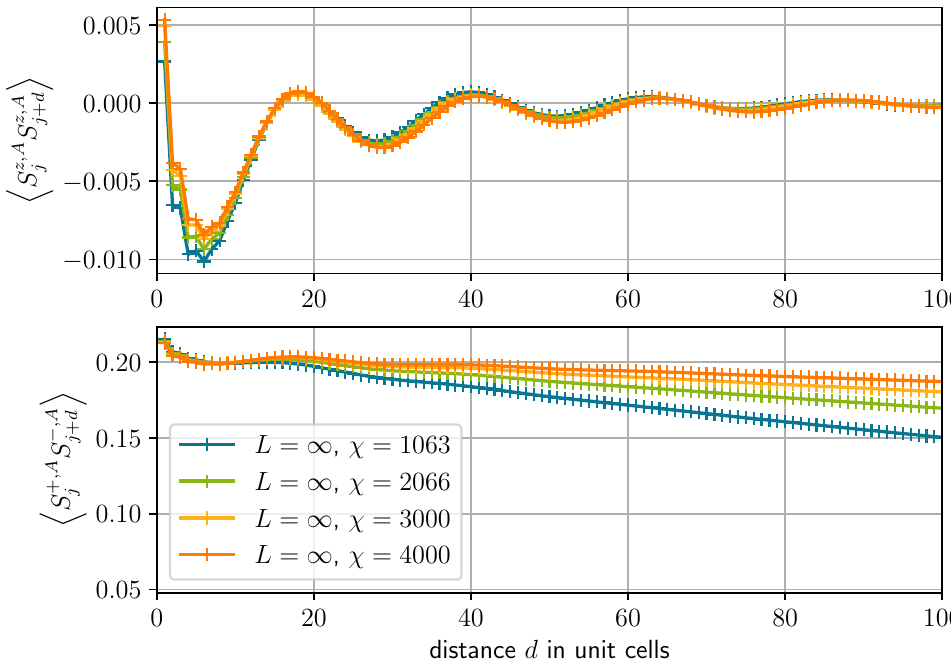
(cid:172) (cid:182) S z , A S z , A (top) j j + d